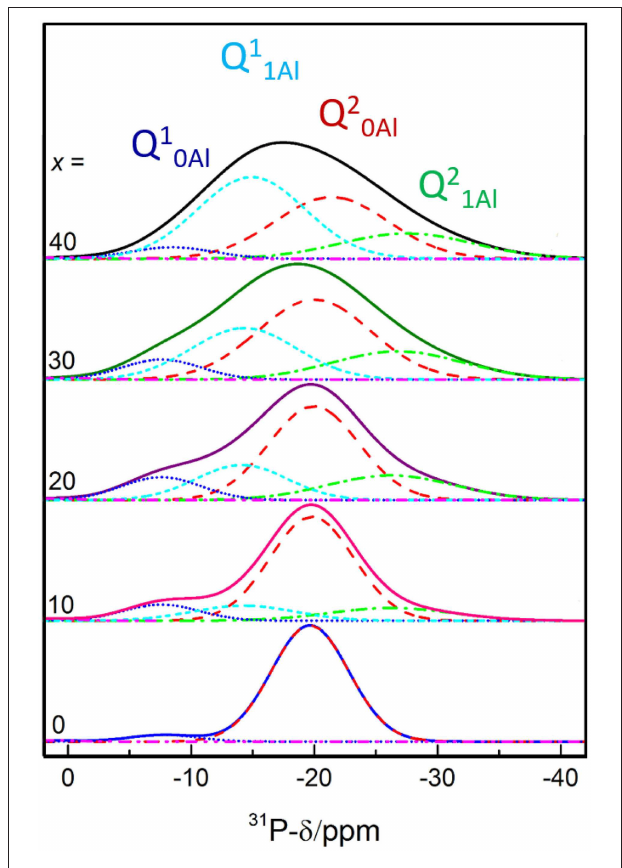
FIGURE 1 | 31 P MAS NMR spectra deconvolutions. Modified and reproduced from Le et al. (2017).